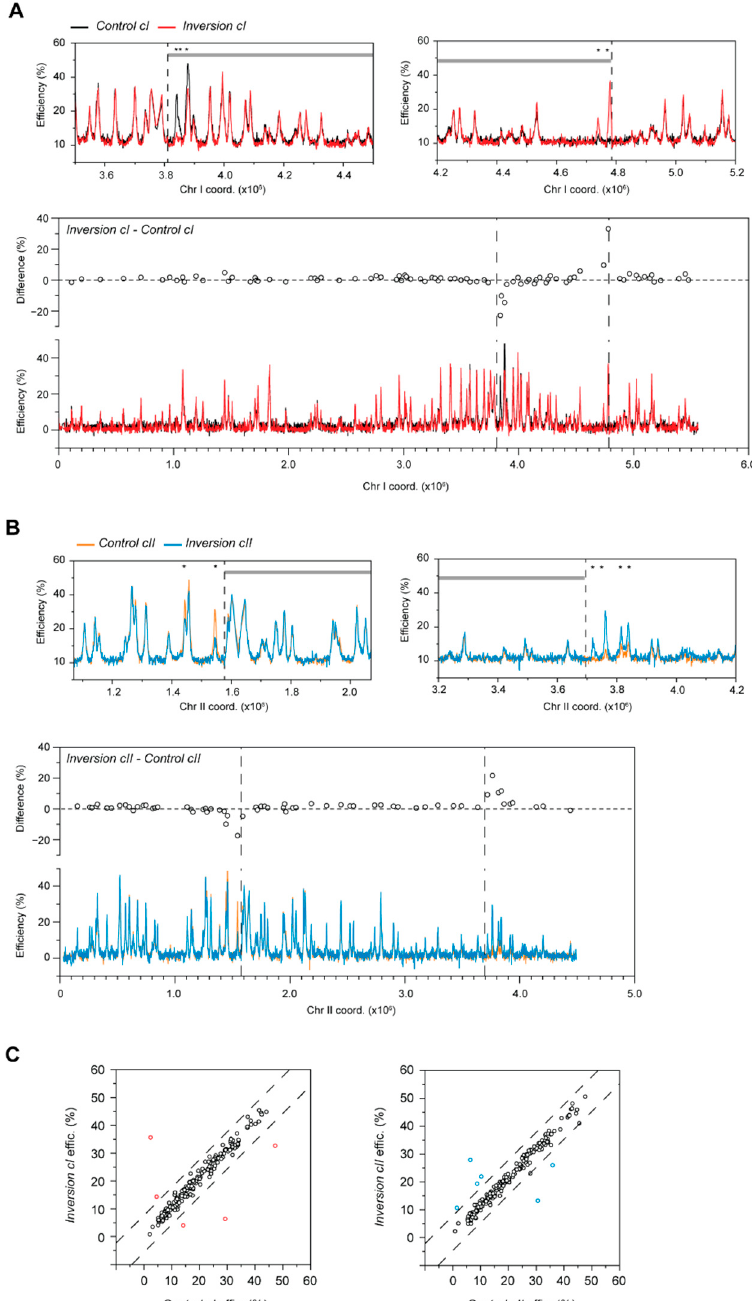
Figure 3. Alterations in the efficiencies of individual origins due to chromosomal inversions in haploid fission yeast. ( A , B ) Differences in replication initiation between Inversion and Control strains. To allow direct comparison with the Control strains, the profiles of Inversion cI and Inversion cII are plotted using the original, pre-translocation coordinates. Only chromosomes harboring the inversions are shown. Black: Control cI , red: Inversion cI , orange: Control cII , blue: Inversion cII . Dashed lines indicate rearrangement endpoints. x -axis: chromosome coordinates; y -axis: origin efficiencies. Top panels: Detailed view of the replication profiles surrounding the inversion endpoints. Alterations in origin usage in Inversion cI occur within the inverted fragment, whereas changes in Inversion cII are located outside of the inversion. Asterisks highlight origins that show significant efficiency differences between the Inversion and Control backgrounds. Gray lines delineate the rearranged fragment. Bottom panels: Position-effect of the impact of chromosomal context on origin firing. Differences in origin efficiencies between Inversion and Control strains (circles, top part of each graph) in post-quiescent S phase. A: chromosome I inversion; B: chromosome II inversion. The bottom parts of the graphs are as in Figure S2. ( C ) Comparison of origin efficiencies in the Inversion vs. Control